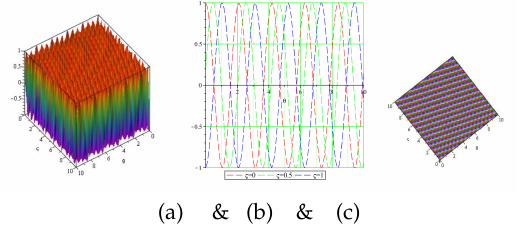
Fig. 1. 3D (left), 2D (middle) and contour (right) surfaces of real part Eq. (29) when µ =